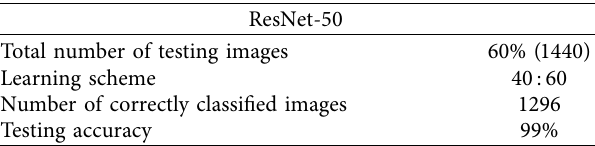
Figure 5: Learning curves and loss for ResNet-50. Table 2: ResNet-50 testing performance